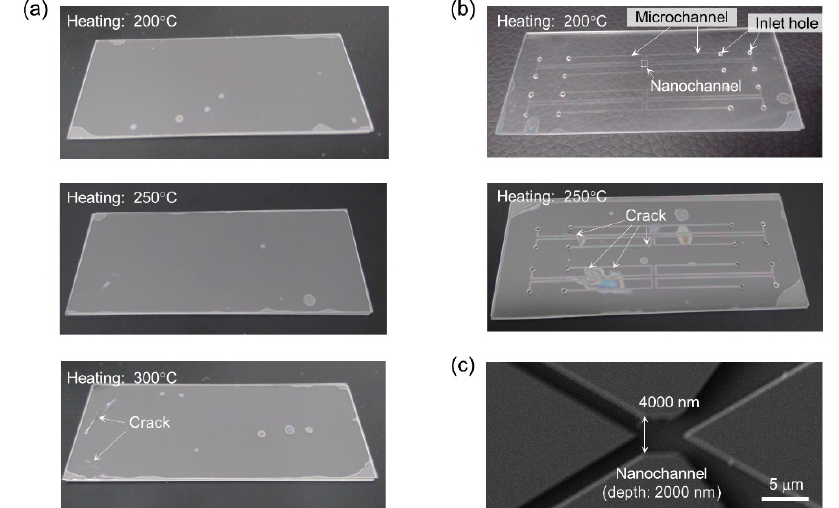
Figure 5. Low-temperature bonding of fused-silica glass substrate (thickness: 0.7 mm) and borosilicate glass substrate (thickness: 0.17 mm). ( a ) Photograph of bonded fused-silica and borosilicate glass substrates. ( b ) Photograph of micro/nanofluidic device fabricated by the bonding of fused-silica substrate with micro- and nanochannels and a borosilicate glass substrate. ( c ) X-shaped nanochannel of 4000 nm wide and 2000 nm deep fabricated in a boxed area indicated on the photograph of micro/nanofluidic device (Figure 4b).